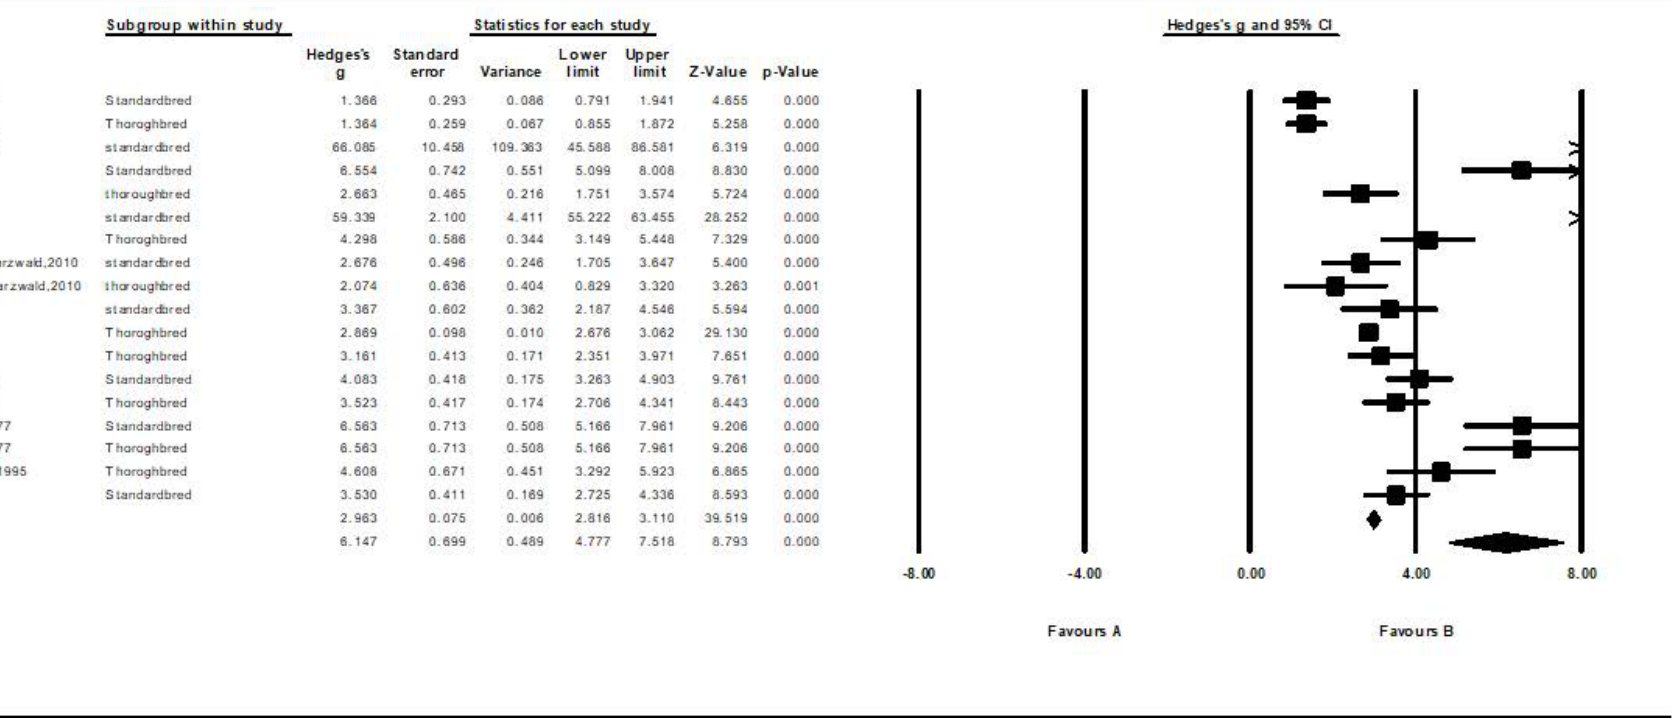
Figure 2. Forest plot for interventricular septum (IVS) measurements in Thoroughbred and Standardbred horses. Studies and their respective citations: Al-Haidar et al., 2013 [35]; Al-Haidar et al., 2010 [2]; Bakos et al., 2002 [21]; Brown et al., 2003 [22]; Buhl et al., 2005 [18]; Collins et al., 2010 [36]; Grenacher and Schwarzwald, 2010 [37]; Kriz et al., 2000 [38]; Leadon et al., 1991 [23]; Long et al., 1992 [39]; Michima et al., 2004 [8]; Patteson et al.,1995 [6]; Pipers and Hamlin, 1977 [7]; Slater and Herrtage, 1995 [20]; Zucca et al., 2008